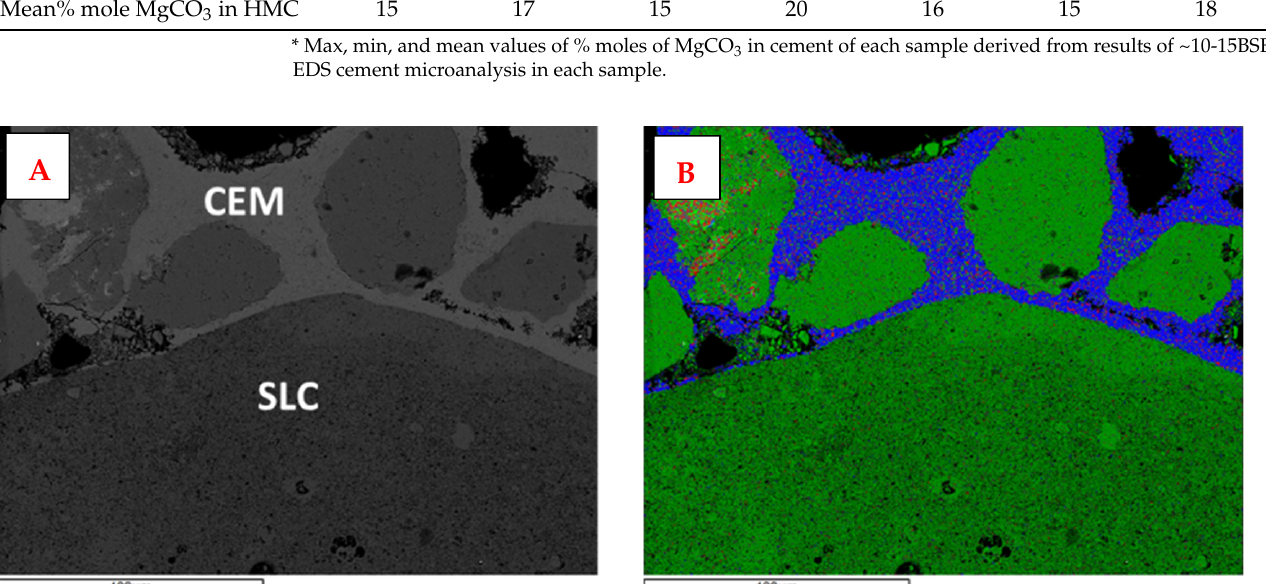
Figure 15. SE image indicating the predominant clayey cement material of KAN2-2 sample which causes its brittle behavior. Table 2. Representative micro analysis of cement in studied samples and the respect % mole Μ gC Ο 3 in calcite lattice. Sample